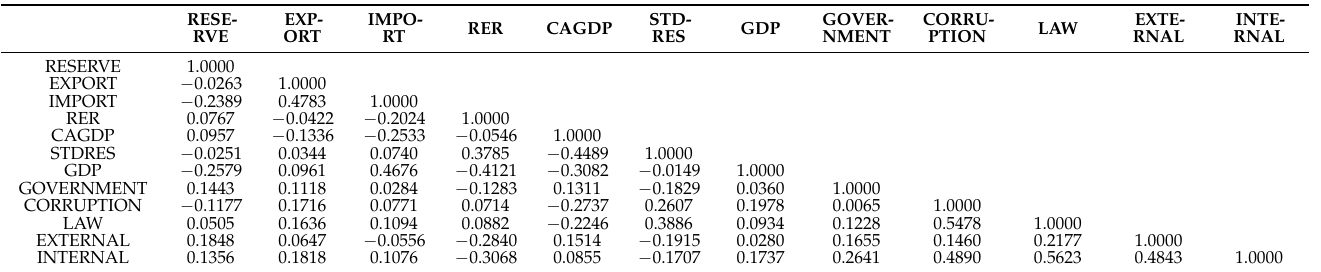
Table 3. Correlation analysis.